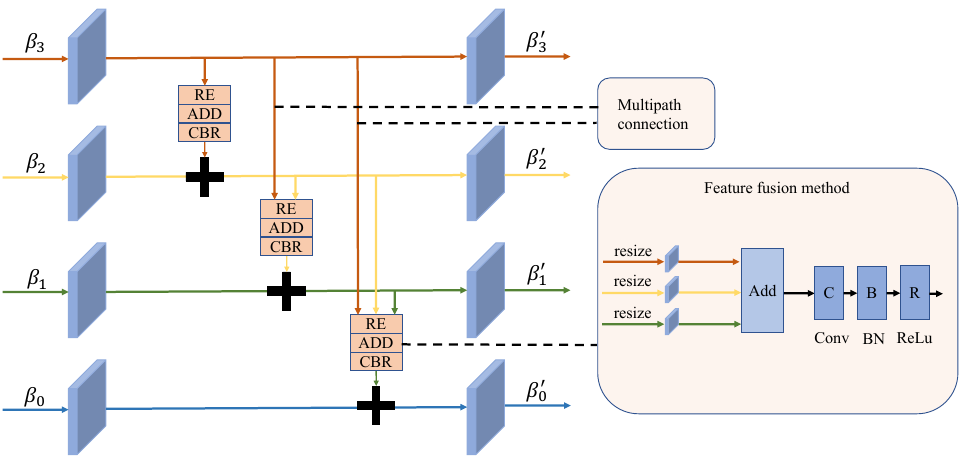
Figure 5. Structure of our proposed